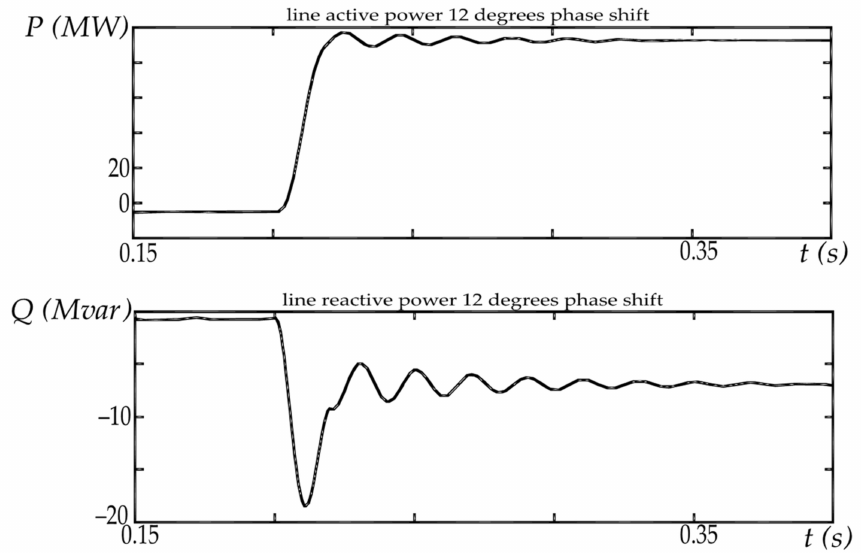
Figure 18. Power-flow interruption after a 12 ◦ phase shift in the MC output voltage for the “as close as possible” approach and the 12 × 12